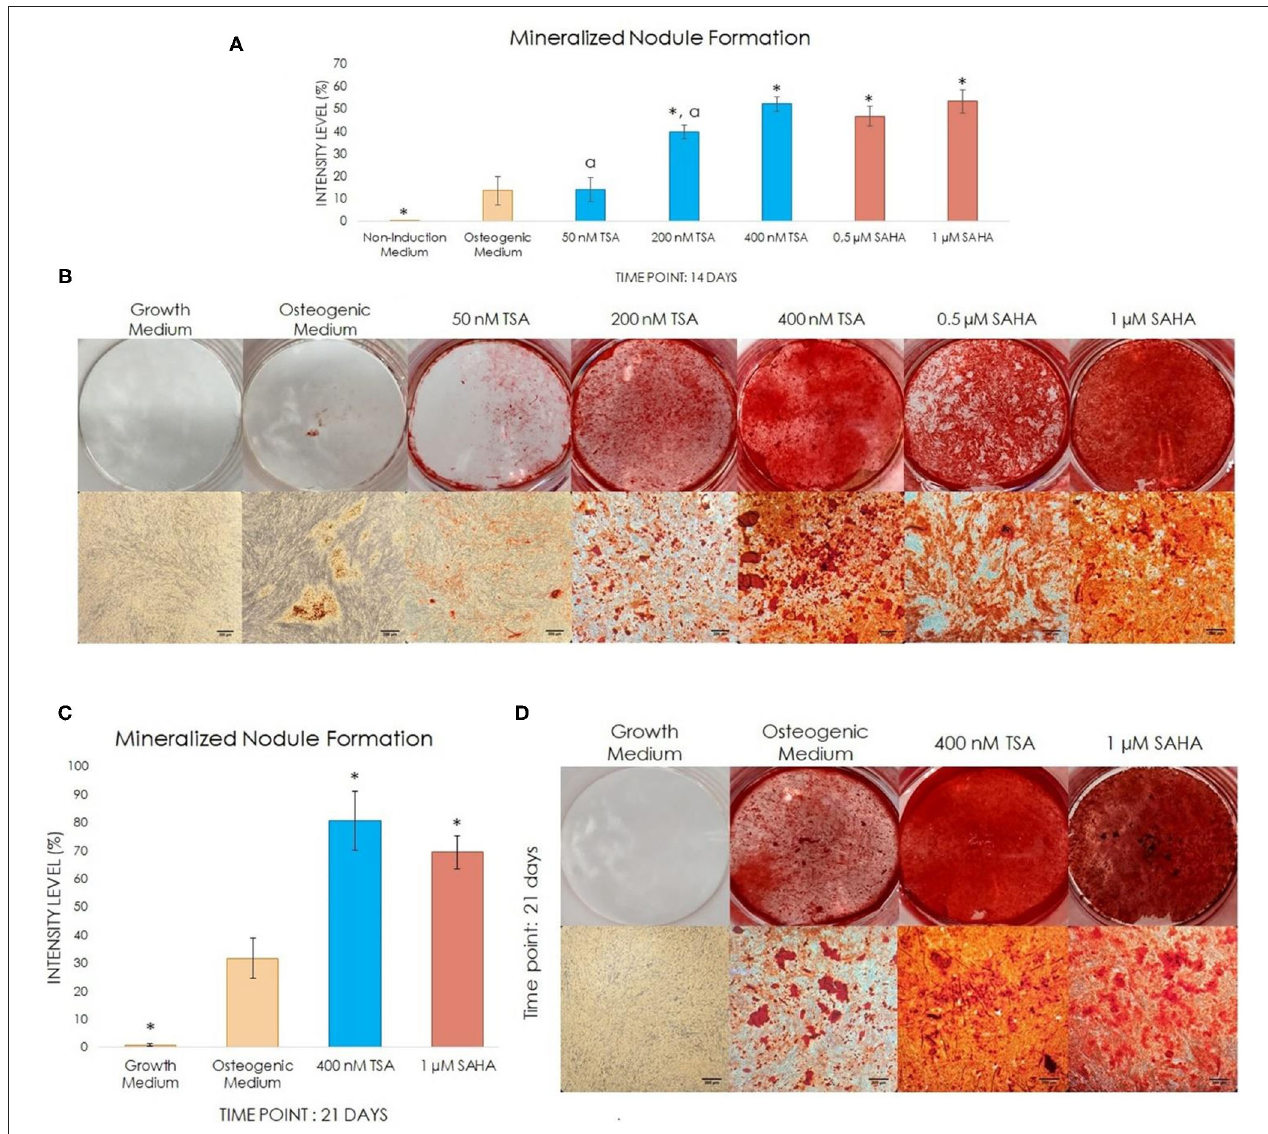
FIGURE 2 | The effect of TSA and SAHA on mineral deposition in hDPCs in non-osteogenic and osteogenic medium with/without TSA or SAHA. (A,C) Quantitative analysis was performed using ImageJ Software representing the percentage of the staining intensity of the mineralized nodule. (B,D) Alizarin Red Staining at day-14 and − 21 post-induction (one-way ANOVA, Tukey’s HSD post hoc test, Asterisks indicate a significant difference compared with osteogenic medium at p < 0.05, a indicates a significant difference between the TSA-treated groups, compared with 400nM TSA at p < 0.05, n = 4).